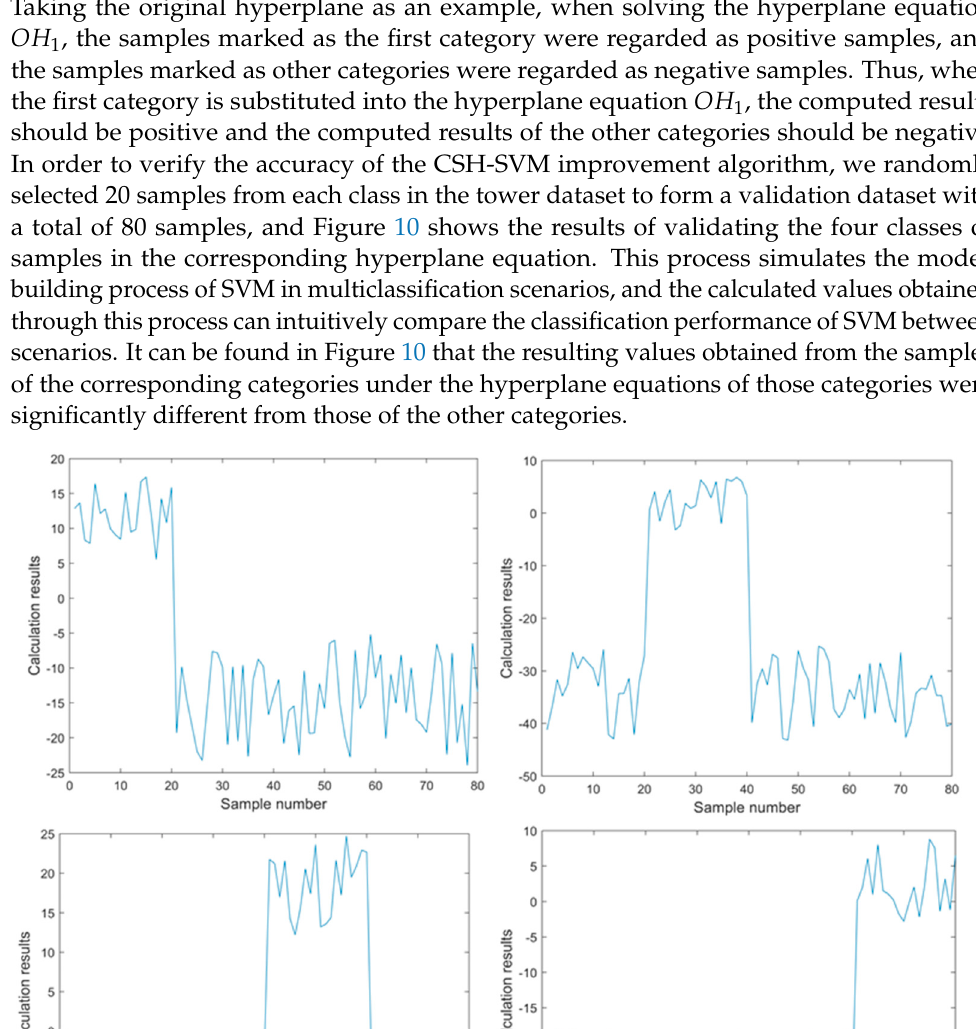
Figure 11. Calculation results of four types of samples under improved hyperplane.